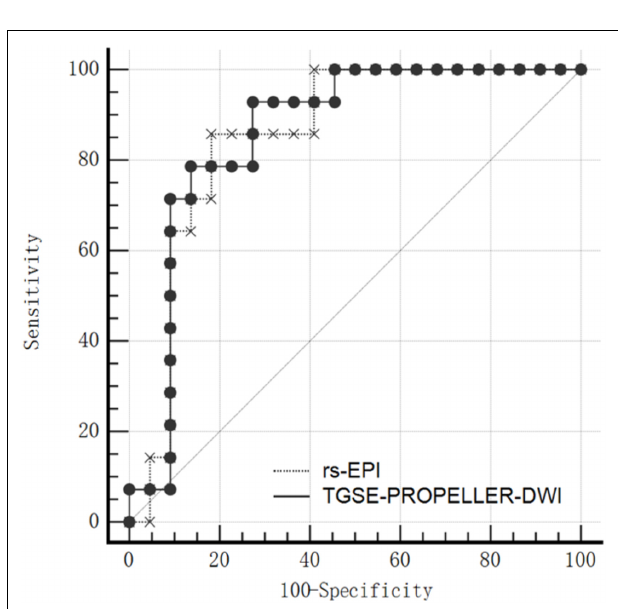
FIGURE 5 | ROC curve of the two DWI ADC values to differentiate malignant and benign orbital tumors.